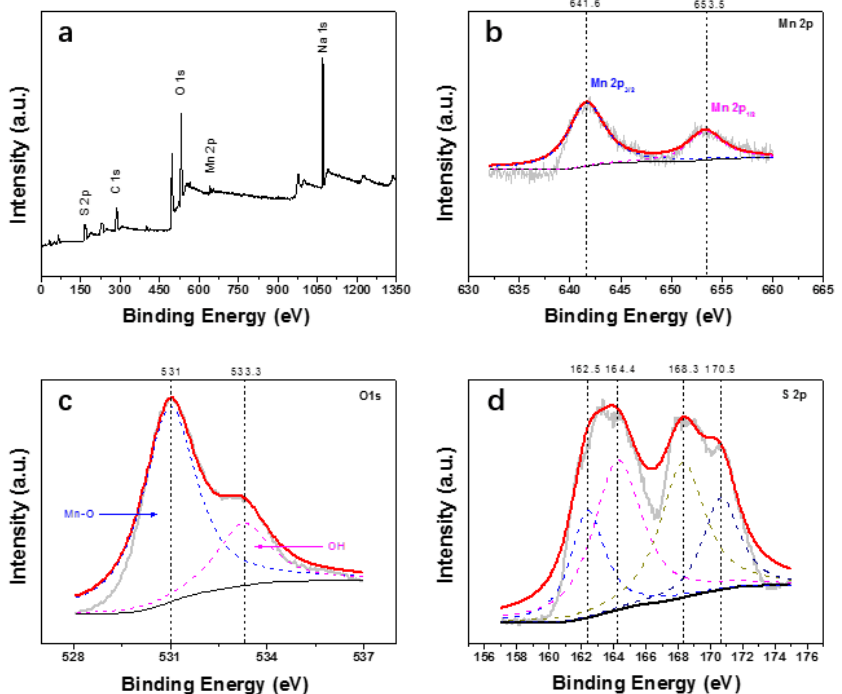
Figure 2. ( a ) The survey spectra of S/Mn 3 O 4 ; ( b ) Mn 2p; ( c ) O 1s and ( d ) S 2p.